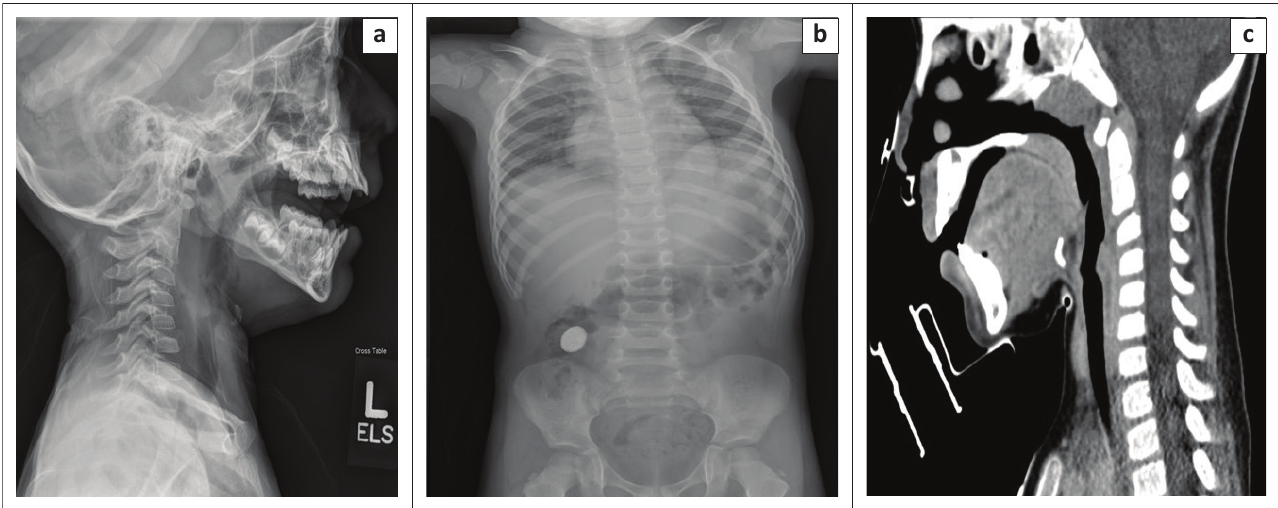
FIGURE 7: Lateral radiograph of the neck (a) and abdominal radiograph (b) of a 3-year-old child taken 3 days after ingestion of a button battery shows mild thickening of the retropharyngeal soft tissue with the foreign body located in the distal ileum. Computed tomography (c) revealed that the retropharyngeal soft tissue noted on the neck radiograph was actually collapsed oesophagus with no collection. The child was managed conservatively without any